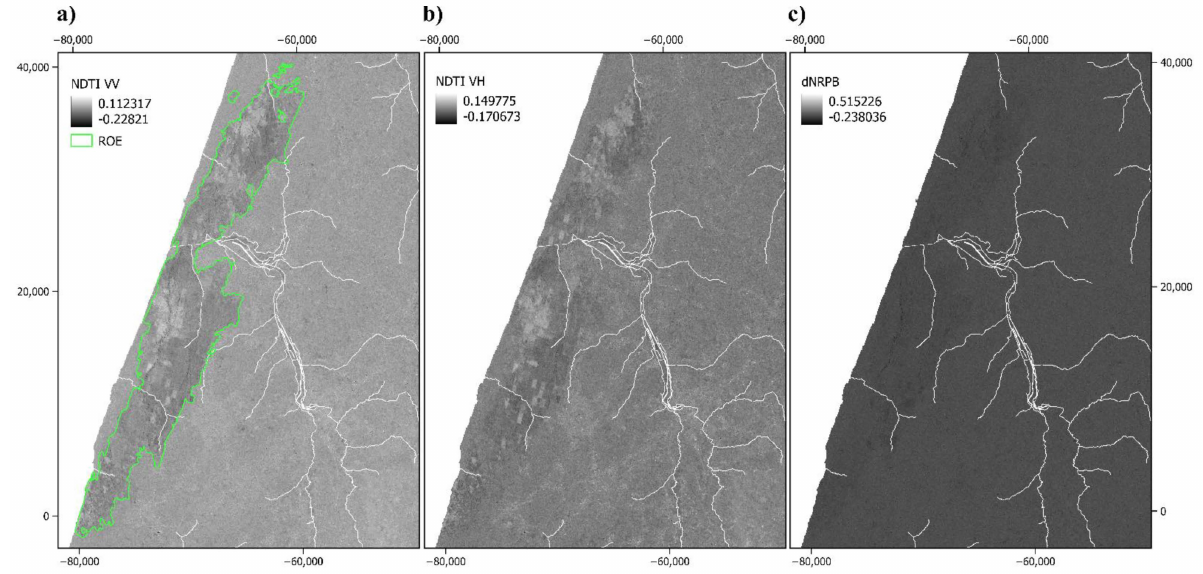
Figure 7. Comparison of SAR-derived index differences (NDTI—Normalized Differenced Temporal Index for both ( a ) vertical-vertical (VV) and ( b ) vertical-horizontal (VH) polarizations; ( c ) dNRPB— difference of Normalized Ratio Procedure between Bands) alongside the delineation of the Reference Observed Event (ROE) [48] for the Leiria National Forest fire (Portugal) (coordinate reference system: